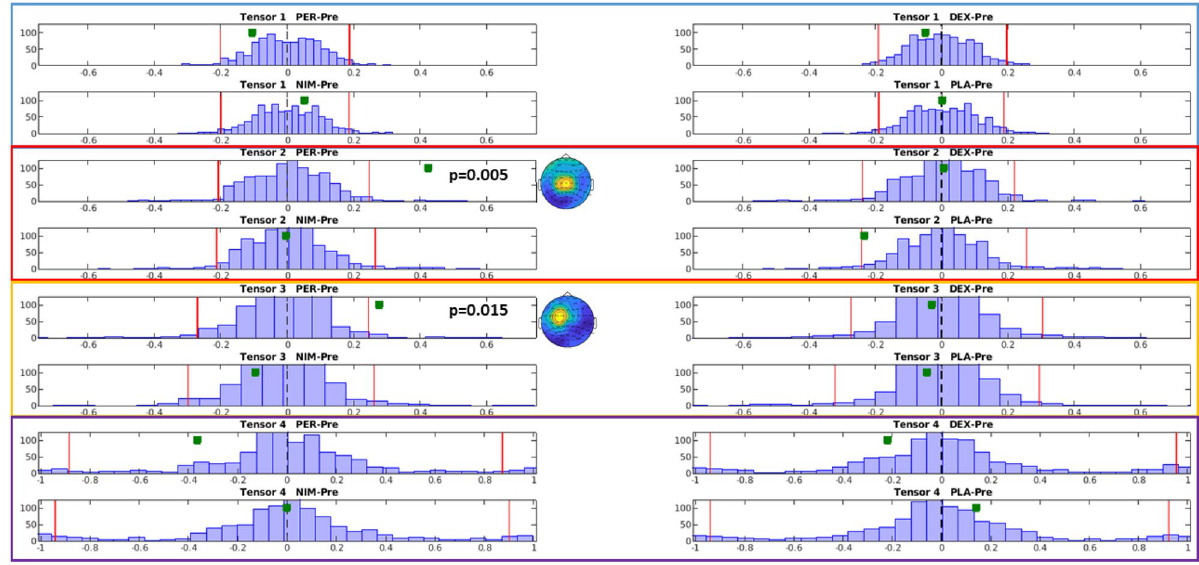
Figure 7. Strength differences of tensor components post–pre drug intake. The 16 histograms show the distribution of strength change post-drug vs. pre-drug out of 1000 iterations for the first (blue frame), second (red), third (yellow) and fourth (violet) tensor components. The shuffling of the data for creating the synthetic dataset was performed on the drug condition dimension. Within the histogram plots, the two vertical red lines define lowest and highest 2.5%. The green squares represent the post–pre difference in the original data (without shuffling). Significant increases were detected for the second and third tensor components after perampanel intake (p < 0.005 and p < 0.015, respectively). PER perampanel, DEX dextromethorphan, NIM nimodipine, PLA placebo, Pre pre-drug intake. Figure generated with MATLAB R2016a (https:// www. mathw orks. com).